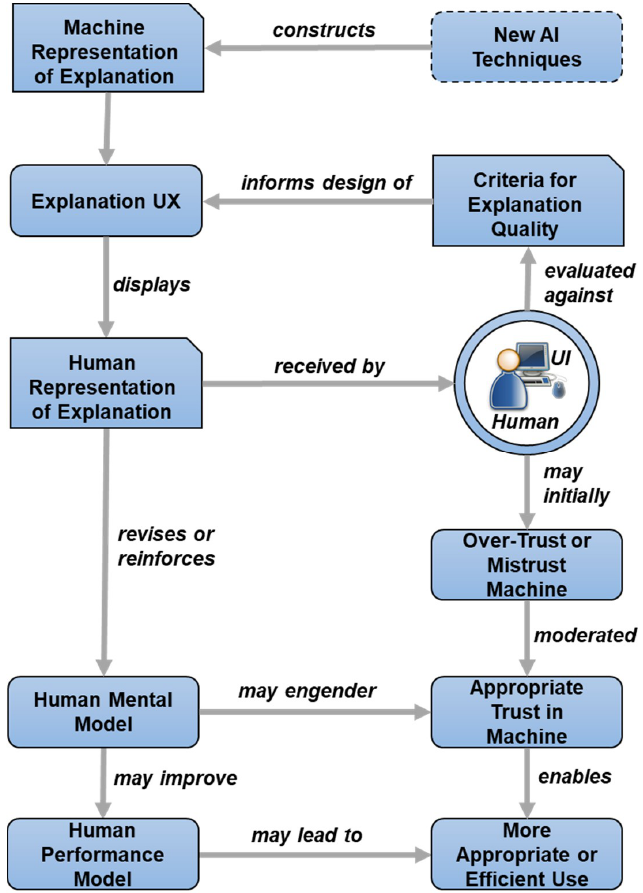
Figure 2. Example of a partial psychological model of explanation. Adapted from [26]. Note the operator interacting with the system via the explanation user interface within the circle.